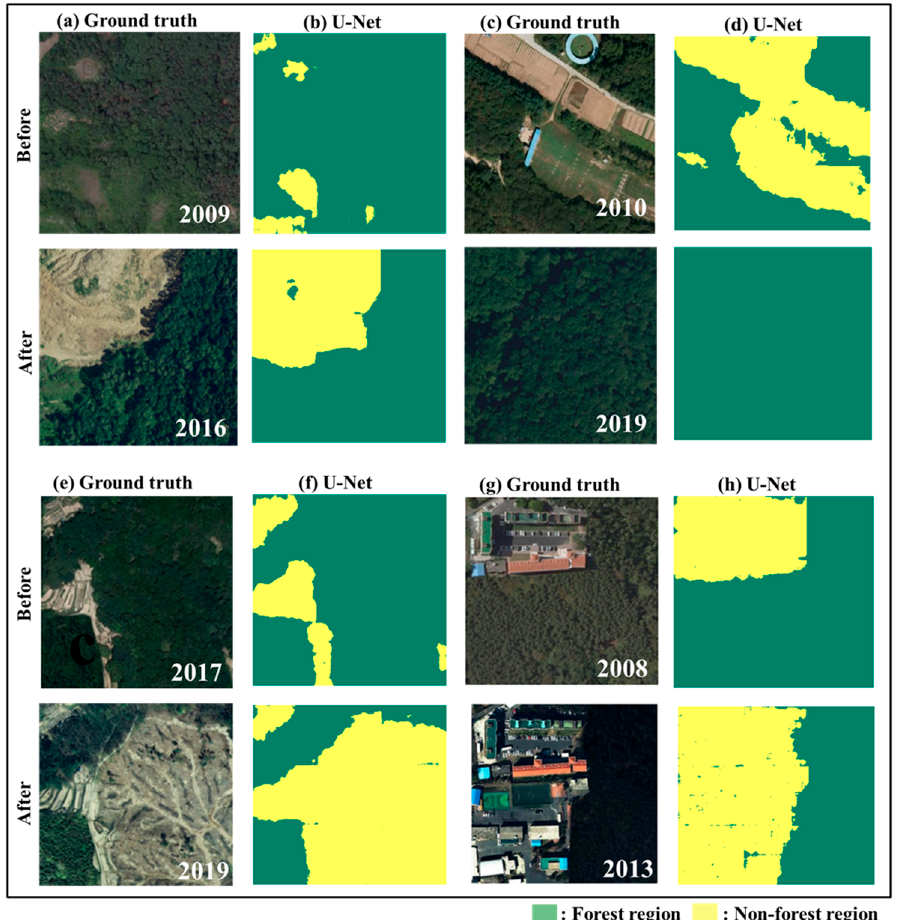
Figure 8. U-Net test performance of classifying forest and non-forest regions in different periods from open map service. ( a , c , e , g ) indicate the RGB images of ground truth in segmented areas and ( b , d , f , h ) are the forest classification results of U-Net in each image pixel. Green color denotes the forest area while yellow indicates non-forest area denoting to 0 and 1,